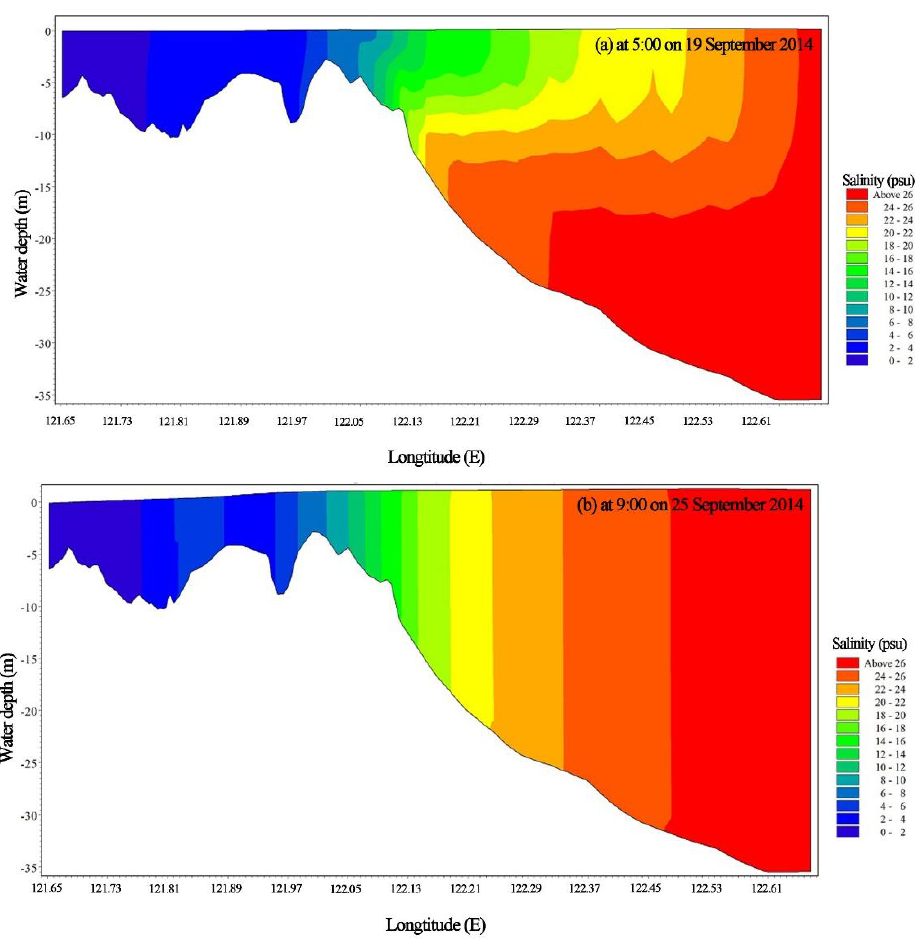
Figure 14. Salinity vertical distribution along the talweg of the NB at ( a ) 5:00 on 19 September in the rising period; ( b ) and 9:00 on 25 September 2014 in the falling period of Typhoon Fongwong.